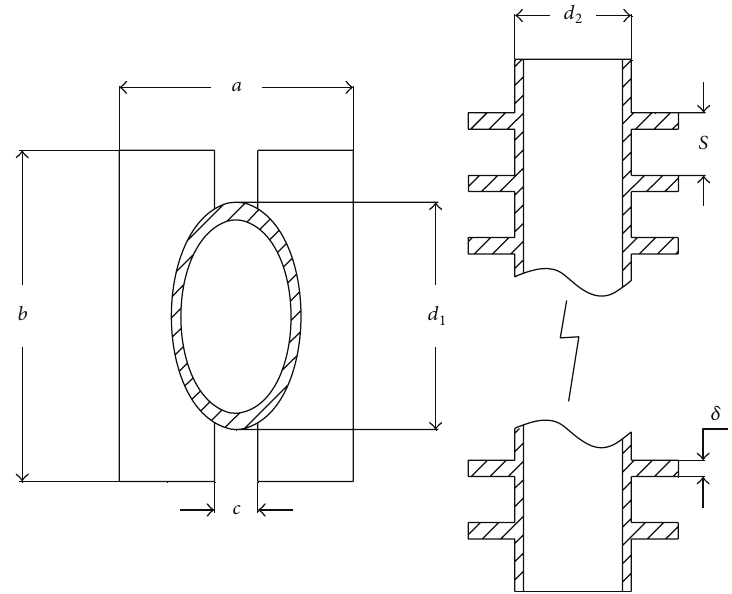
Figure 2: Geometrical sketch of the tube of experiment I.